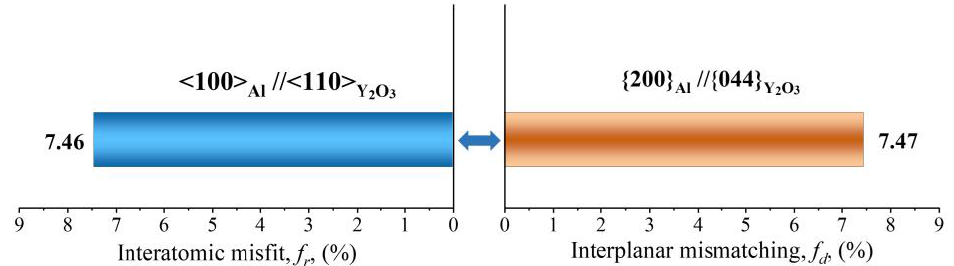
Figure 11. Schematic diagram of the interplanar spacing mismatch and the interatomic spacing misfit between Y 2 O 3 and Al.